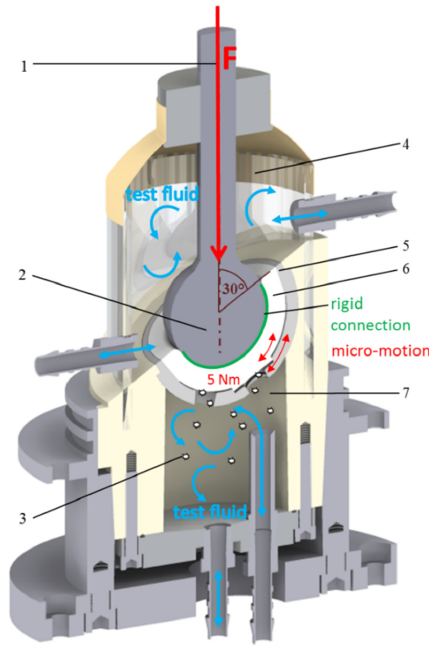
Figure 1. Test setup according to the two-chamber principle: ( 1 ) load axis, ( 2 ) artificial femoral head, ( 3 ) backside wear particle, ( 4 ) articulation area, ( 5 ) cup system, ( 6 ) PE insert, ( 7 ) backside area [9].